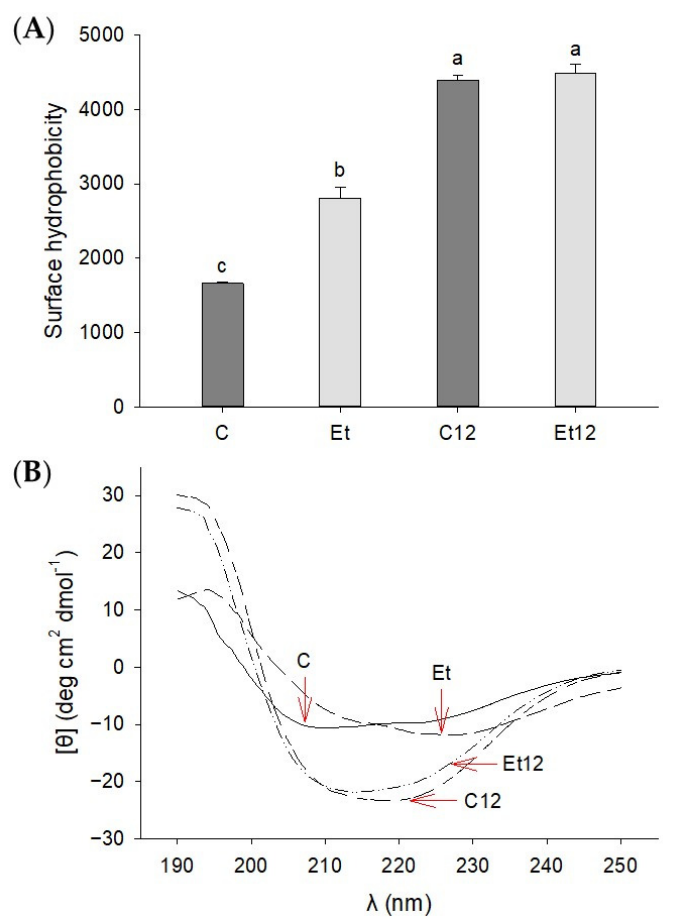
Figure 4. Surface hydrophobicity ( A ) and circular dichroism ( B ) of dephenoled canola protein isolate with or without pH 12 shift treatment. Samples: C: control; Et: dephenoled with 70% ethanol; C12 and Et12: pH 12 shift-treated samples. Bar values with different letters (a–c) are significantly different ( p < 0.05).